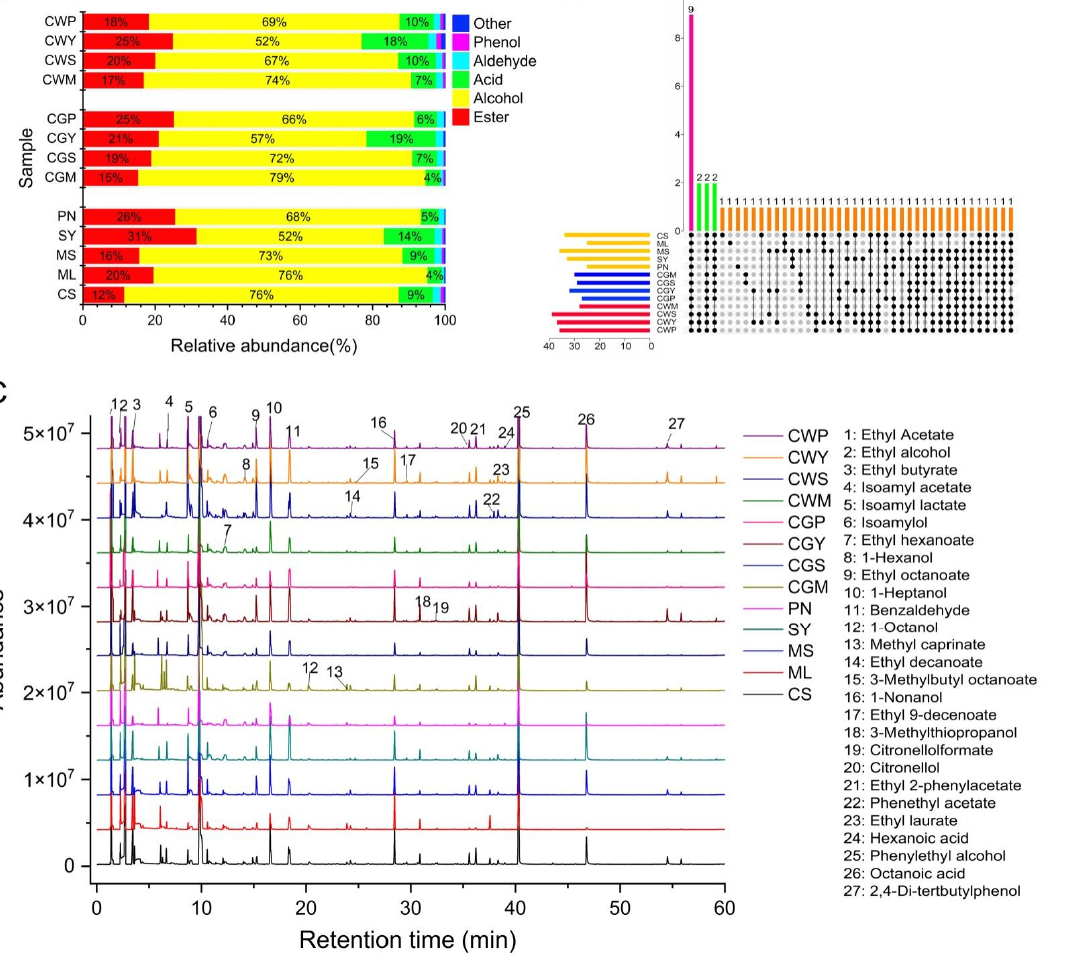
Figure 7. The composition of volatile compounds in wines ( A ). The upset diagram of the wine samples ( B ). Black dots indicate the common aroma compounds in the sample. Different colors represent different treatments and a common number of aroma compounds. The total ion chro ‐ matogram of wine samples ( C ).